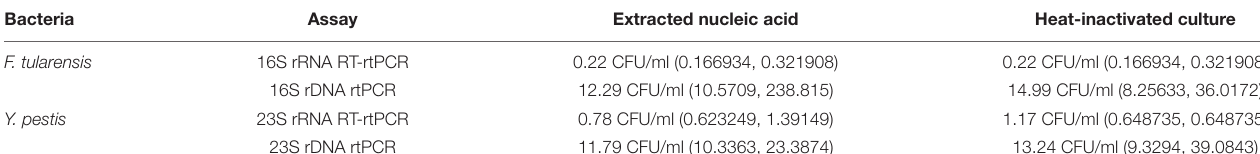
TABLE 2 | Sensitivities of rRNA- and rDNA-targeted PCR assays of F. tularensis and Y. pestis determined by Probit analysis. Bacteria Assay